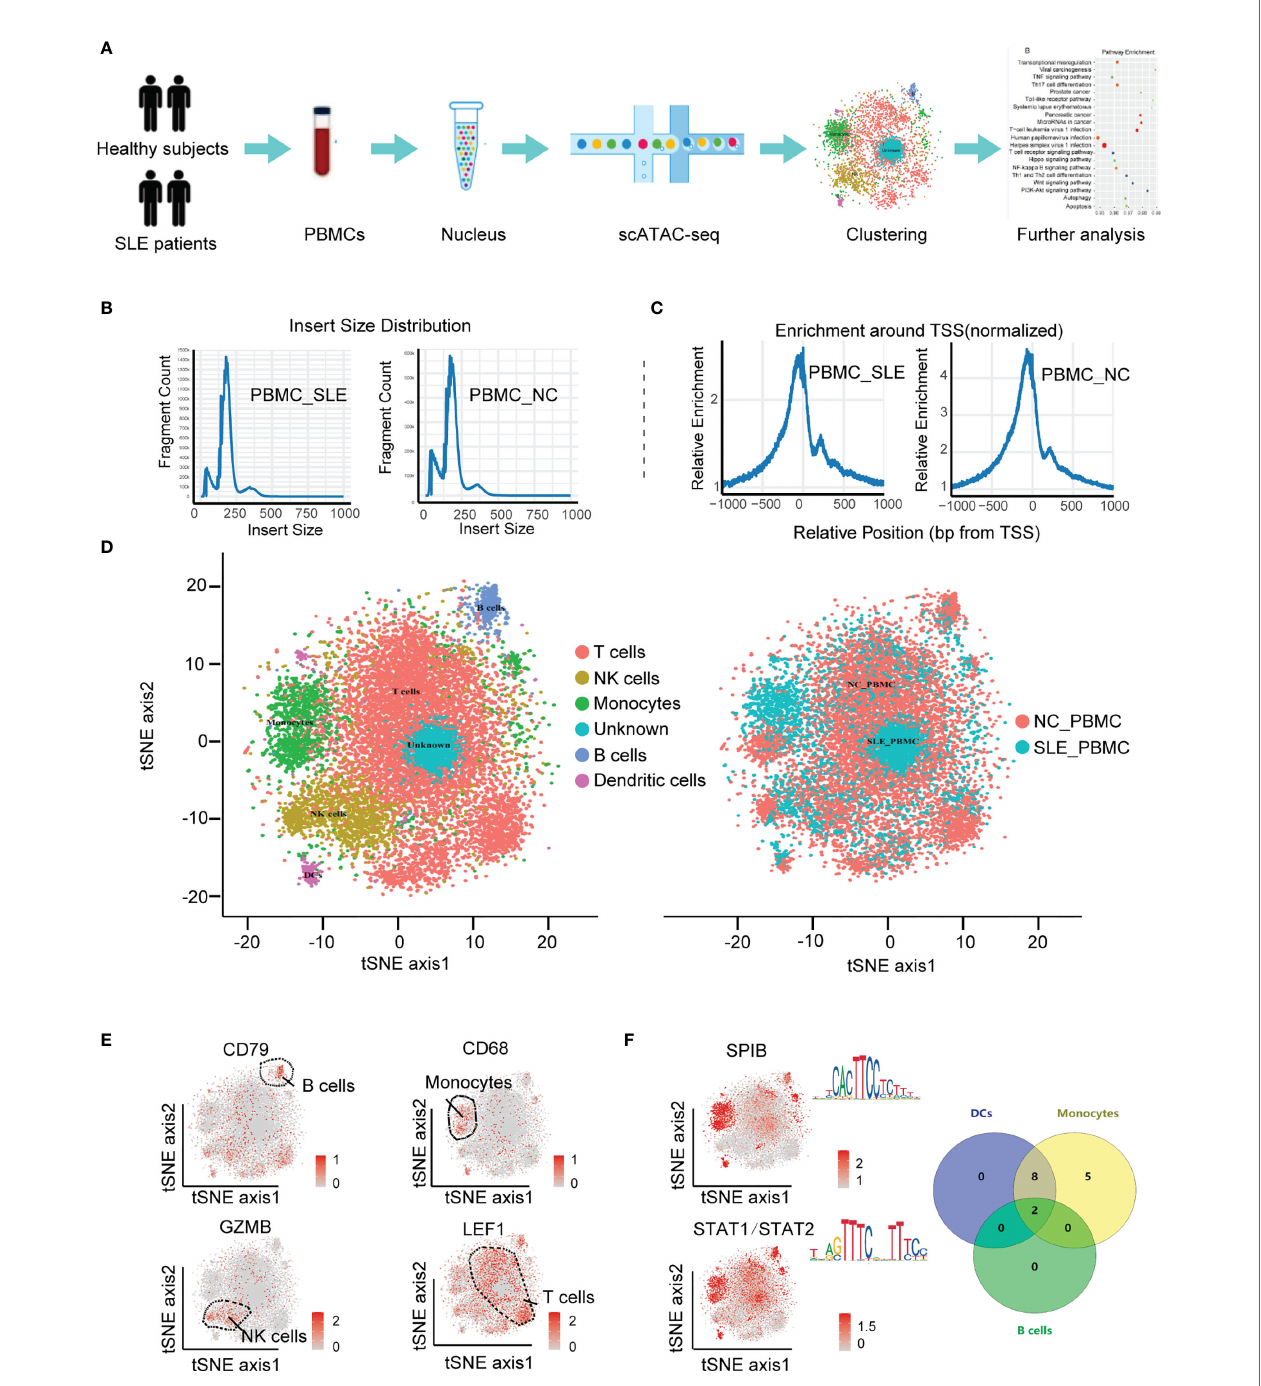
FIGURE 1 | Cell-type-speci fi c clustering of human PBMCs according to scATAC-seq. (A) Schematic showing the process of isolating PBMCs for scATAC-seq; (B) Histogram of the distribution of fragment lengths in reads from the SLE_PBMC and NC_PBMC groups; (C) Histograms showing enrichment of fragments at TSSs; (D) tSNE plot of cellular populations in the SLE_PBMC and NC_PBMC groups; (E) tSNE plot of canonical cell markers used to label clusters, color-coded for expression levels (gray to red); (F) tSNE plot of cell type-speci fi c TF motifs (left), color-coded for expression levels (gray to red), and Venn diagram showing the distribution of 15 TF motifs with signi fi cantly differences (p <0.05) between different clusters (right). PBMCs, peripheral blood mononuclear cells; scATAC-seq, assaying transposase-accessible chromatin in single-cell sequencing; SLE_PBMC, PBMCs from patients with systemic lupus erythematosus (SLE); NC_PBMC, PBMCs from healthy controls; NK cells, natural killer cells; DCs, dendritic cells; TF, transcription factor; TSSs, transcription start sites. The p-values were calculated with Loupe Cell Browser 3.1.1 through the difference analysis feature and adjusted using the Benjamini – Hochberg correction for multiple